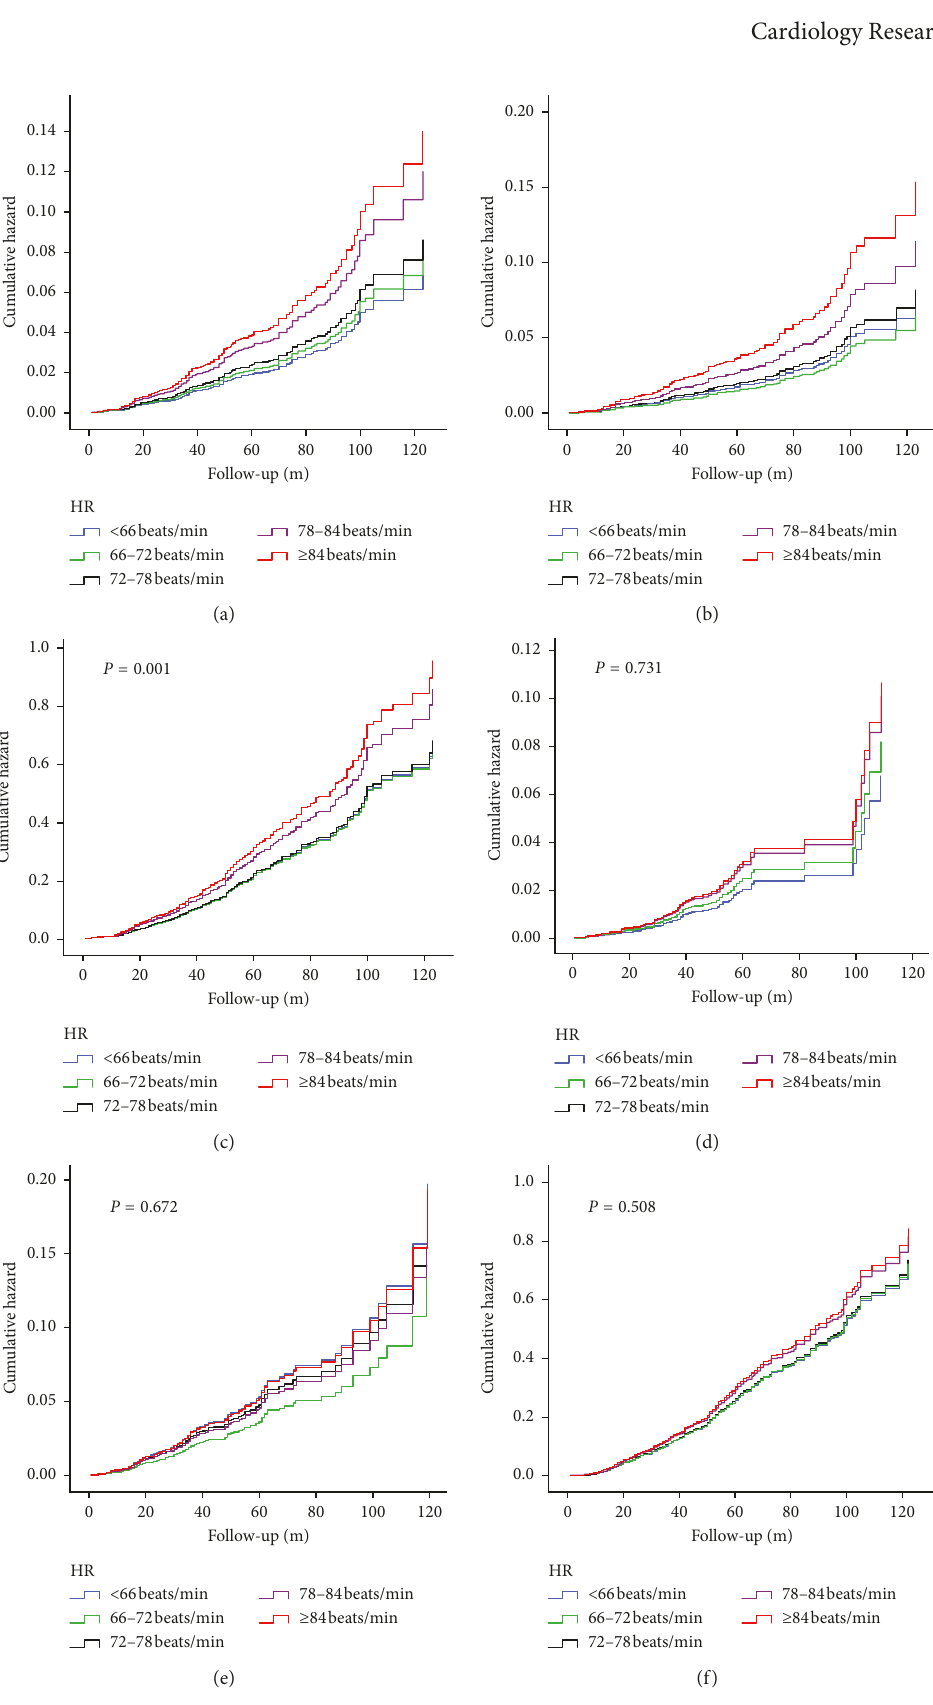
Figure 2: Cumulative Kaplan–Meier estimates of the time to the first adjudicated occurrence of primary endpoint and secondary endpoints: (a) ACM; (b) CM; (c) MACEs; (d) stroke; (e) bleeding; (f)